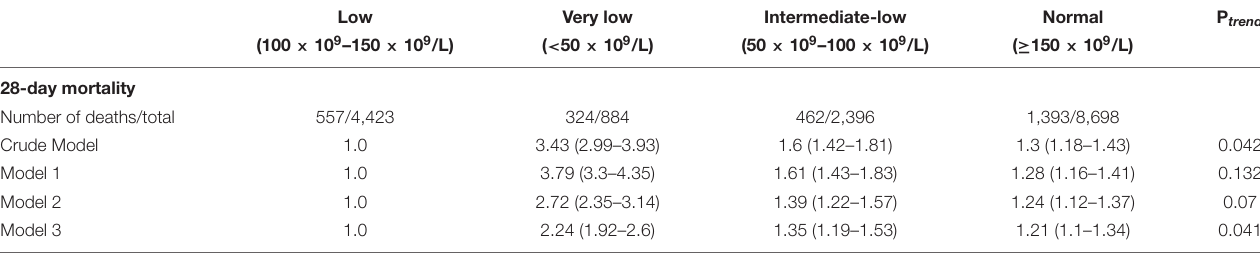
TABLE 3 | Relationship between platelet count and 28-day mortality in patients with sepsis. Low Very low